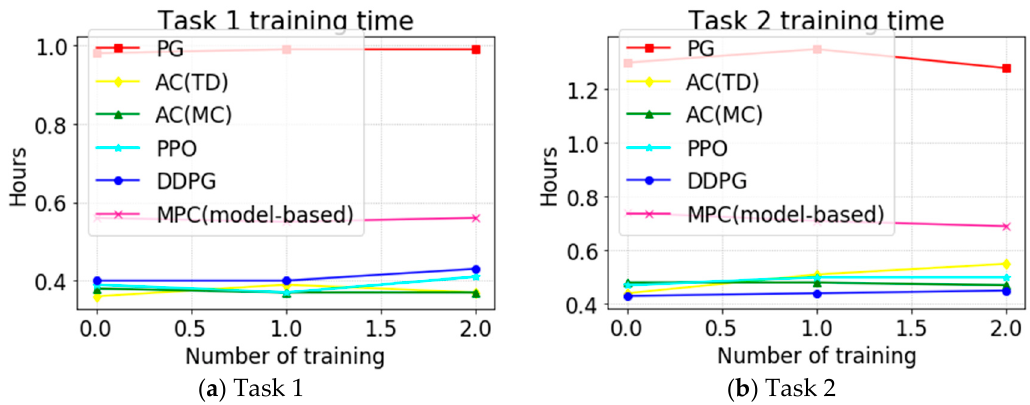
Figure 11. Training times of algorithms.